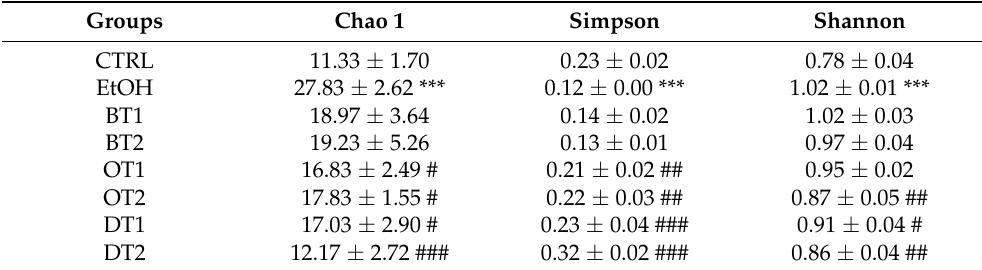
Table 2. The effects of teas on gut microbial community richness and diversity.